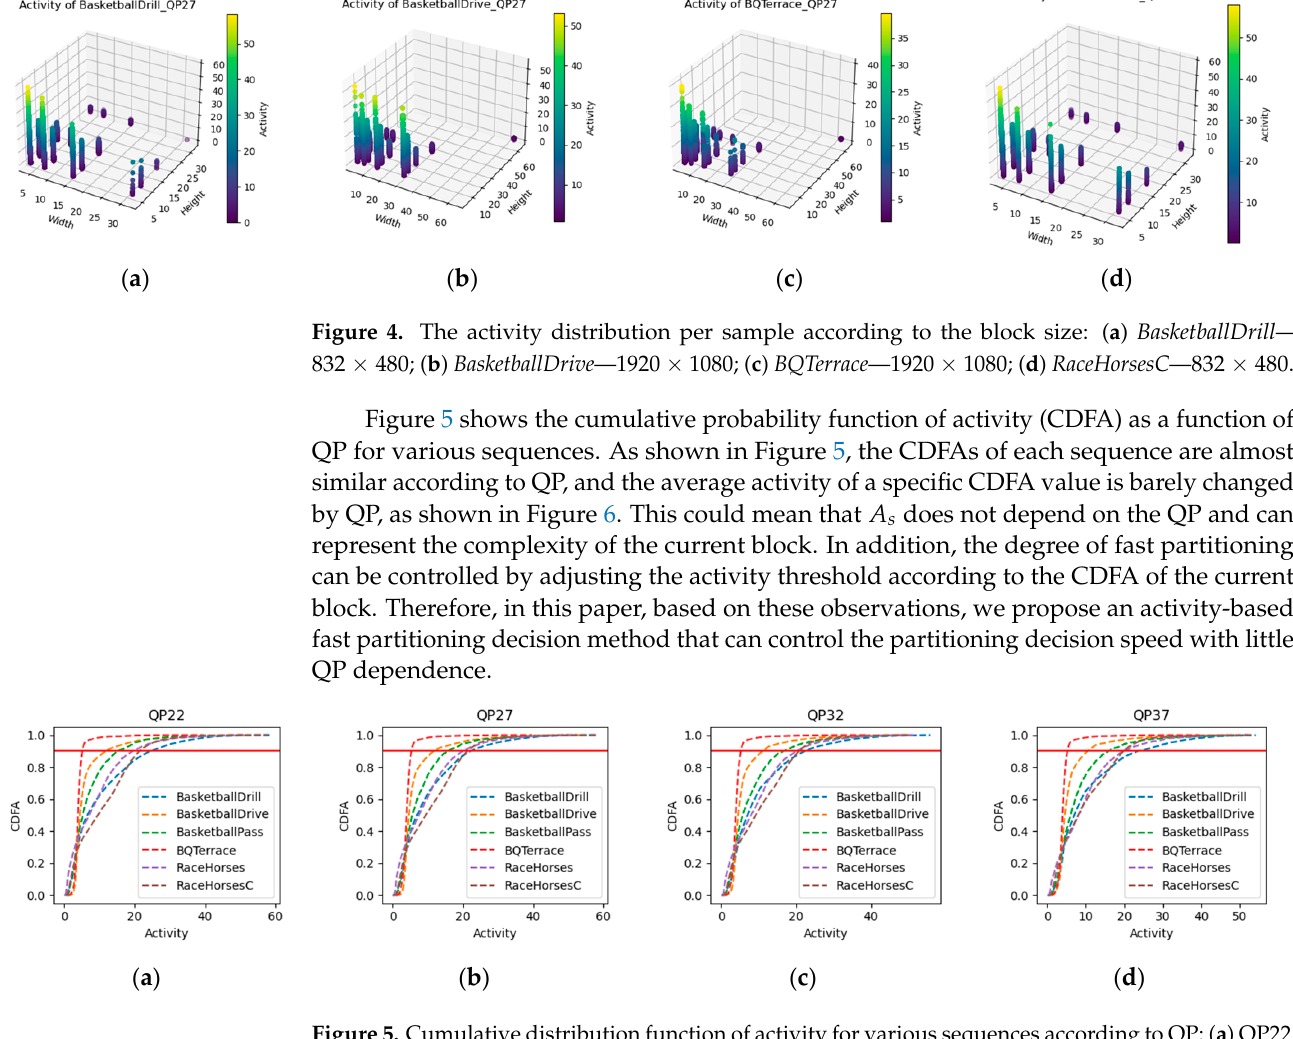
( d ) Figure 3. Original, sample-wise gradients, and activity with overlapping block partitions (Blue boxes: QT, Green boxes: BT-/TT-H, and Red boxes: BT-/TT-V): ( a ) Original; ( b ) Horizontal split with 𝑔 (cid:3049) ; ( c ) Vertical split with 𝑔 (cid:3035) ; ( d ) All split with 𝐴 .